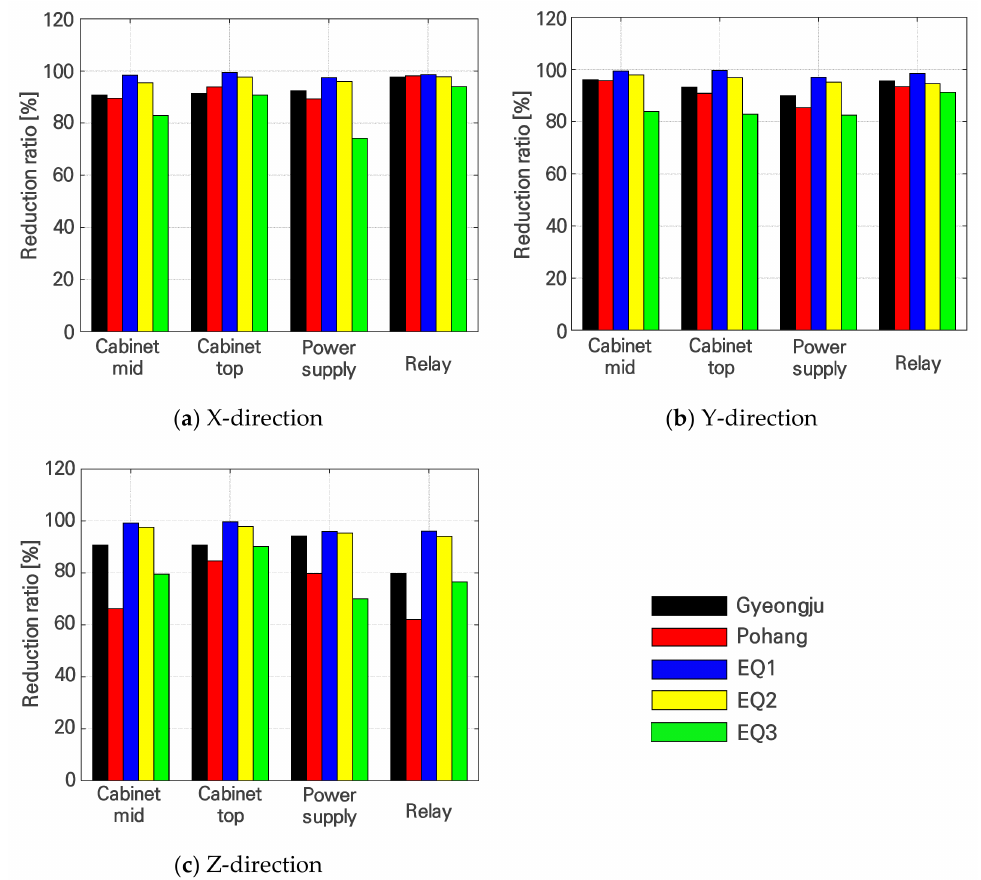
Figure 13. Ratio of peak accelerations (Case 2/Case